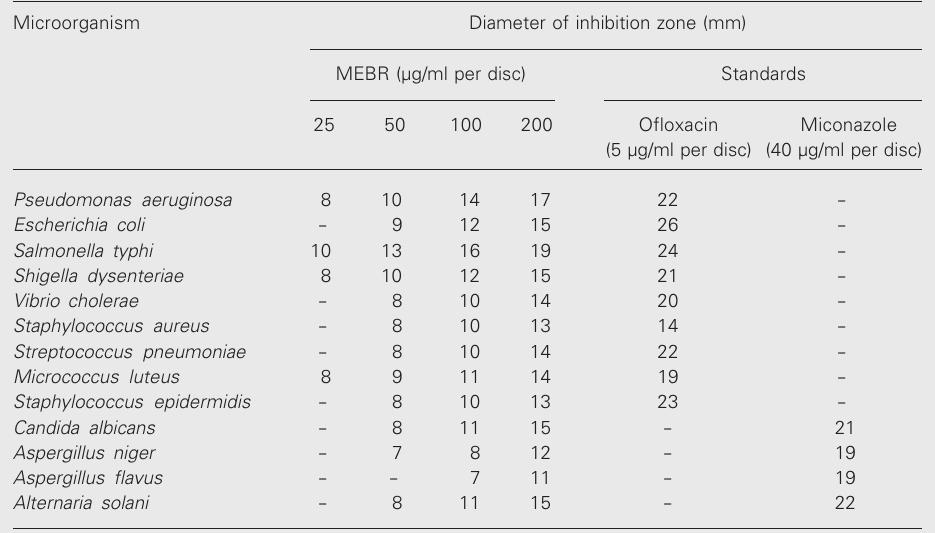
Table 1. Antimicrobial activity of the methanol extract of Bauhinia racemosa stem bark, ofloxacin and miconazole nitrate on selected bacterial and fungal